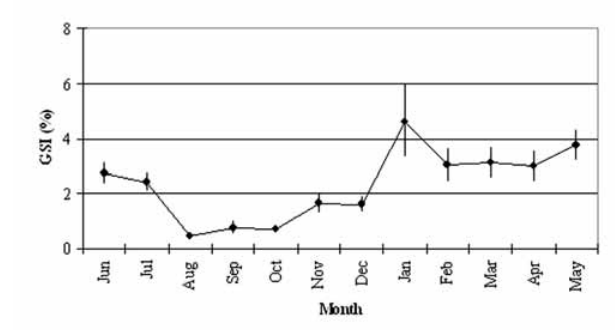
F IG . 8. – Monthly variation of the GSI for M. azevia females. The bars represent the mean ± 95% confidence